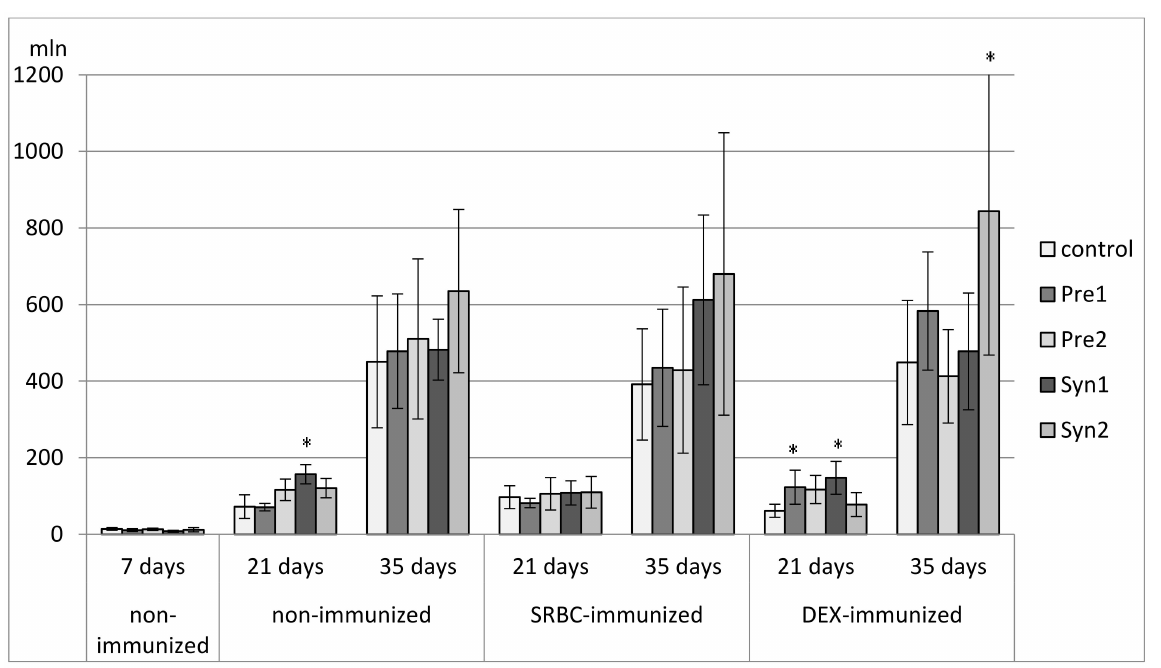
Figure 13. The total count of CD3 + TCR γδ + cells in the spleen of chicken broilers after in ovo injection of the investigated prebiotics or synbiotics. The data are expressed as the mean ± SD. Data with a symbol (*) denote a significant difference with respect to the control group ( p <